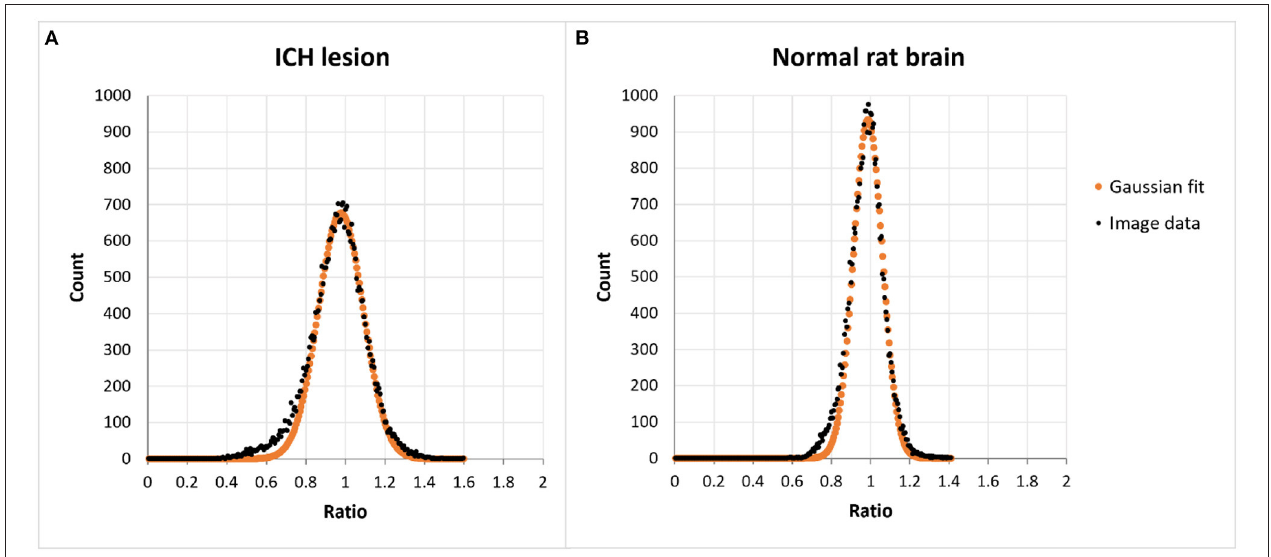
FIGURE 1 | Histograms of the voxel values present in ratio-images obtained by voxel-wise dividing a PET image with the normal rat brain atlas template obtained from (A) an animal with an ICH lesion and (B) a normal [18F]-FDG rat brain scan. In animals with a lesion there is a higher prevalence of lower ratios without affecting the peak